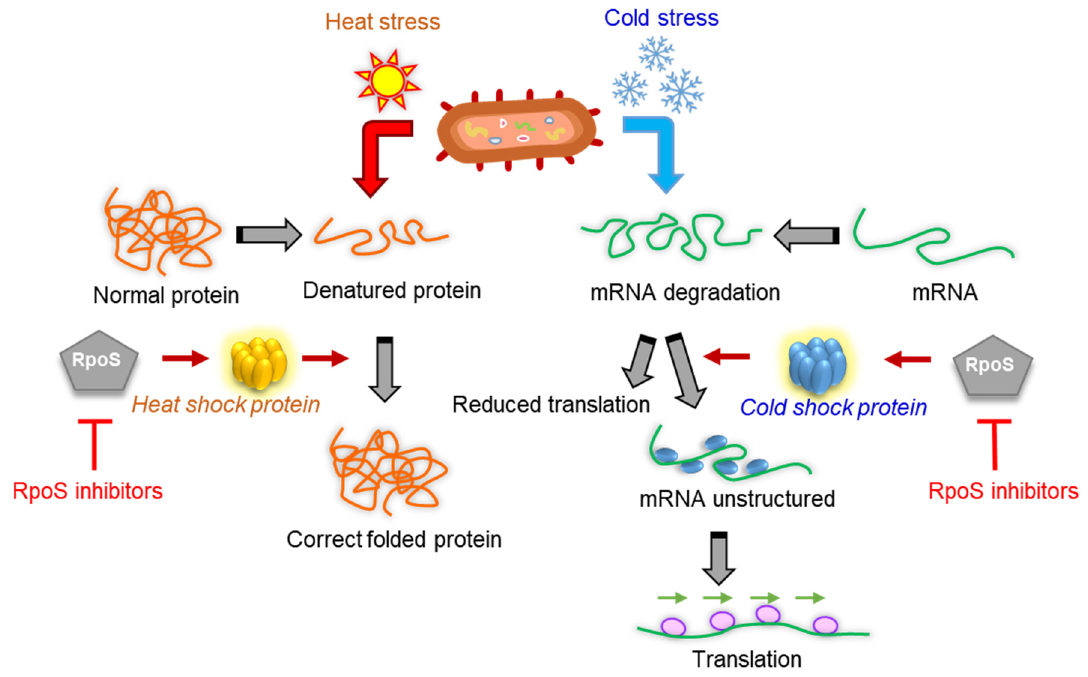
Figure 6. Heat and cold stress responses in bacteria.